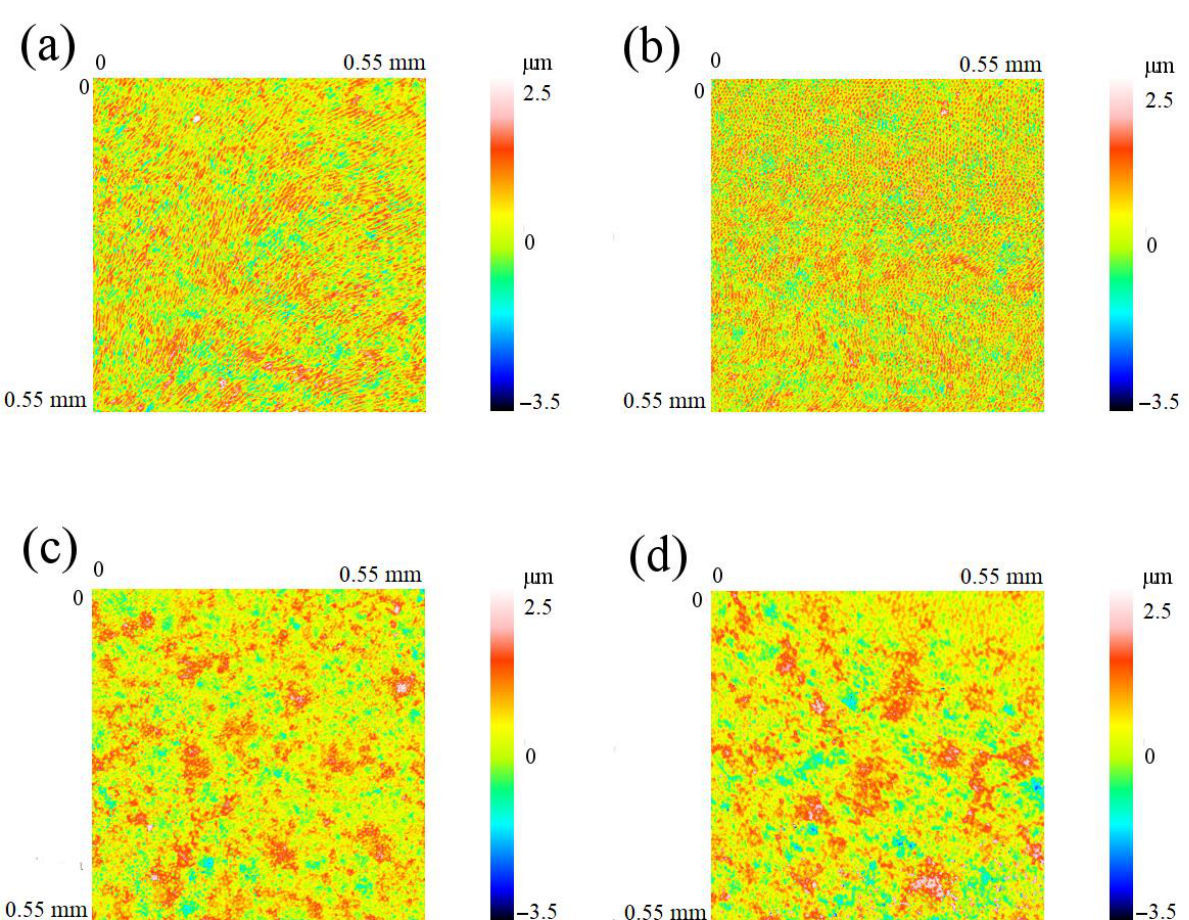
Figure 6. Results of the white-light interferometry (optical 3D profilometry) with color-coded repre- sentation of the surface topography: ( a ) enamel test sample; ( b ) enamel control sample; ( c ) dentin test sample; ( d ) dentin control. Table 2. Mean Ra values from three test and control samples obtained from optical and mechanical profilometry. Significant differences between the test and control groups are marked by (*).